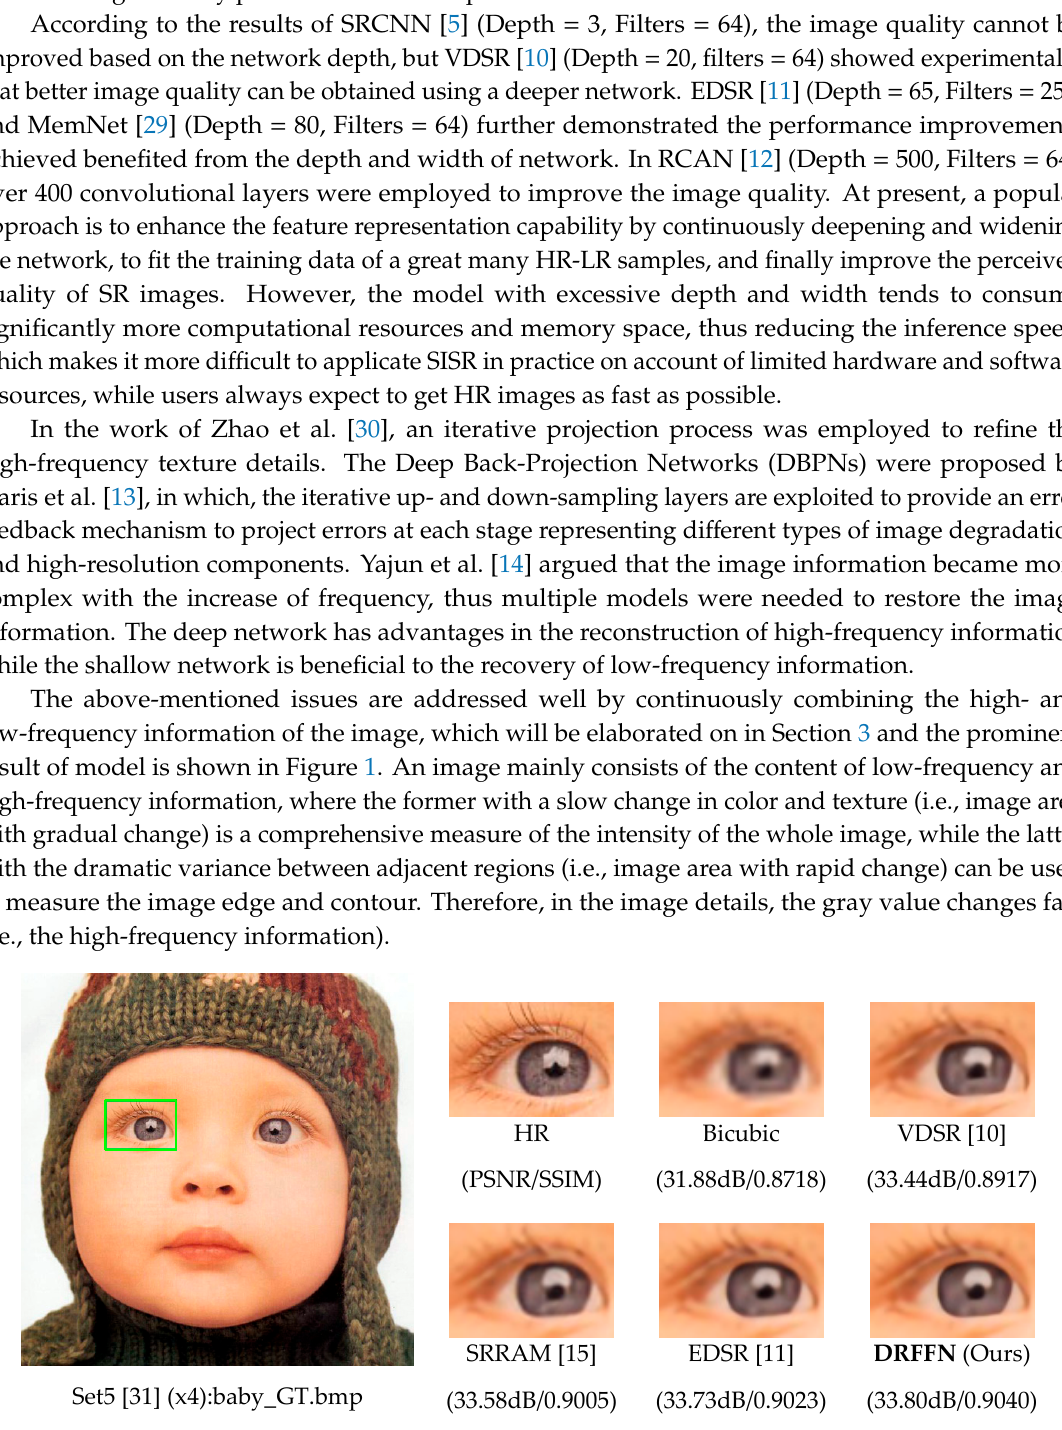
Figure 1. The super-resolution (SR) result of deeply-recursive low- and high-frequency fusing network (DRFFN) with an upscaling factor 4 compared with other models (cited from [10,11,15,31]).